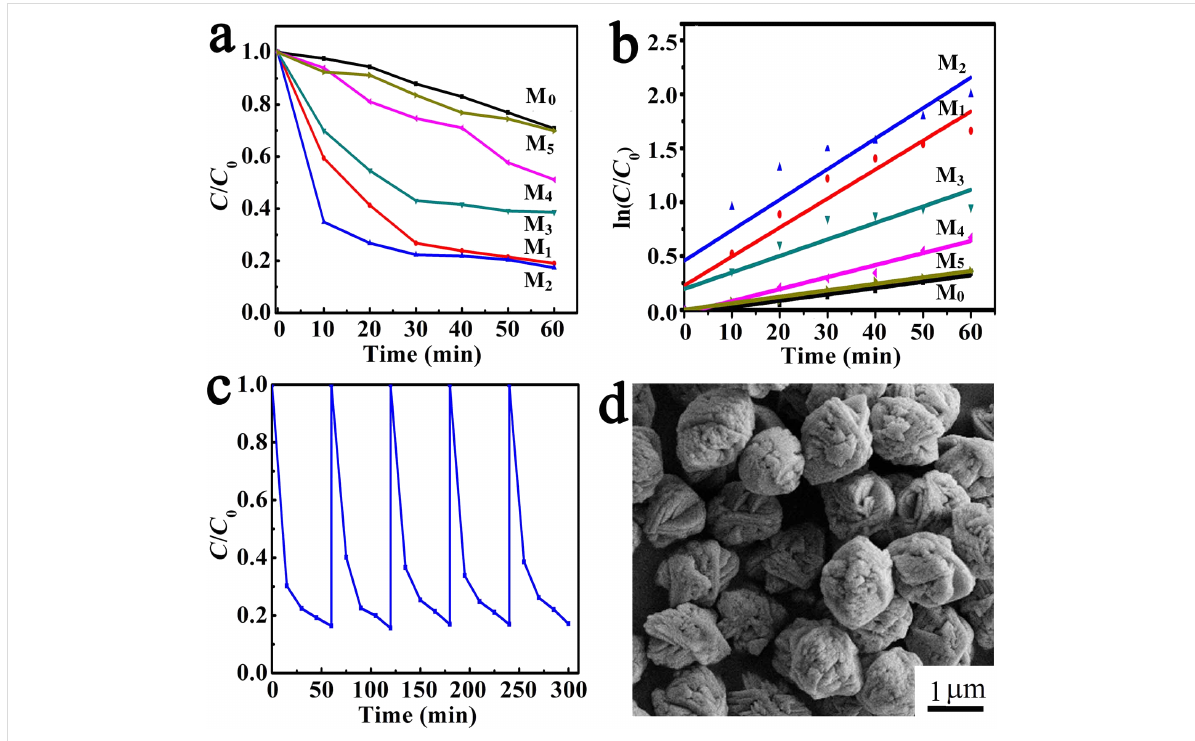
Figure 5: (a) Photocatalytic degradation of oxytetracycline over M 0 , M 1 , M 2 , M 3 , M 4 , M 5 . (b) Kinetic curves for the oxytetracycline degradation with M 0 , M 1 , M 2 , M 3 , M 4 , M 5 . (c) The cycle curves of oxytetracycline degradation using M 2 as a photocatalyst. (d) TEM images of M 2 after five cyclic ex-